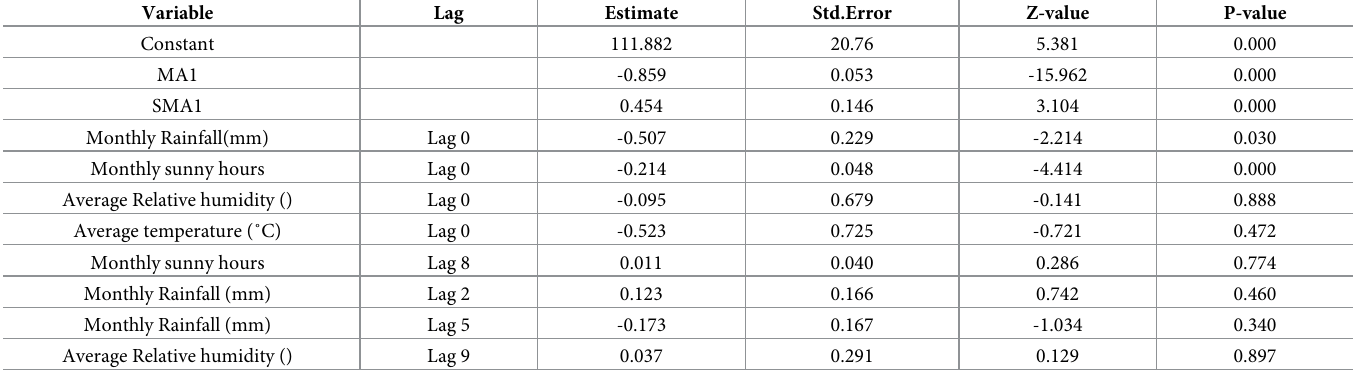
Table 3. Coefficients and statistics of multivariable ARIMA (0,1,1) (0,0,1) 12 time series model of cutaneous leishmaniasis during 2014–2020 in Kerman province, Iran.